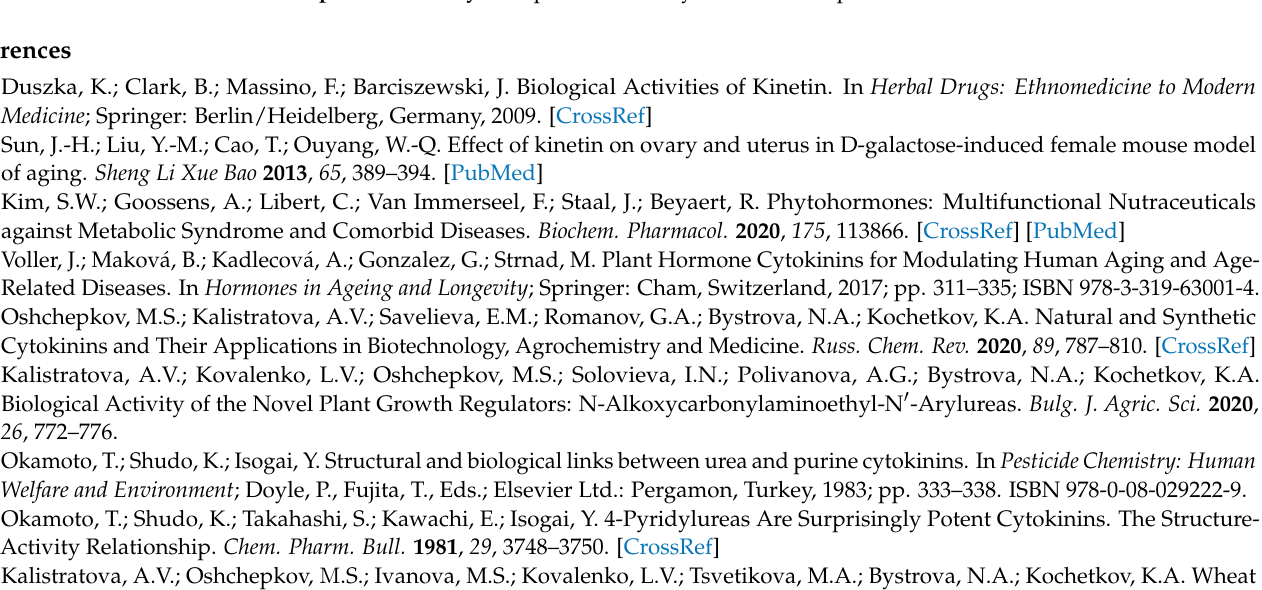
the synthesized compounds. Table S1: Affinities of the clusters for the A2AR receptor variant 5mzj. Table S2: Affinities of the clusters for the A2AR receptor variant 2ydo. Table S3: Affinities of the clusters for the A2AR receptor variant 5mzp. Table S4: Affinities of the clusters for the APRT variant 6hgs. Table S5: Affinities of the clusters for the APRT variant 6hgr. Table S6: Affinities of the clusters for the APRT variant 6hgp. Table S7: Affinities of the clusters for the CDK2 variant 5fp5. Table S8: Affinities of the clusters for the CDK2 variant